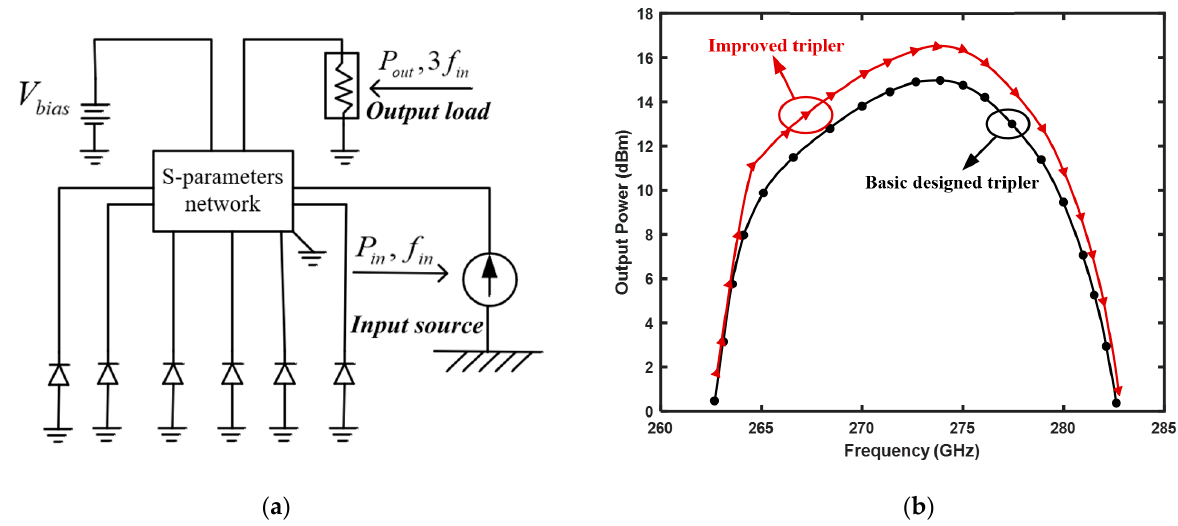
Figure 4. S-parameter network model and results. ( a ) Nine-port s-parameter network model and ( b ) Simulation results of basic designed frequency tripler and improved frequency tripler (Output power vs. 𝑅 (cid:3046) ).